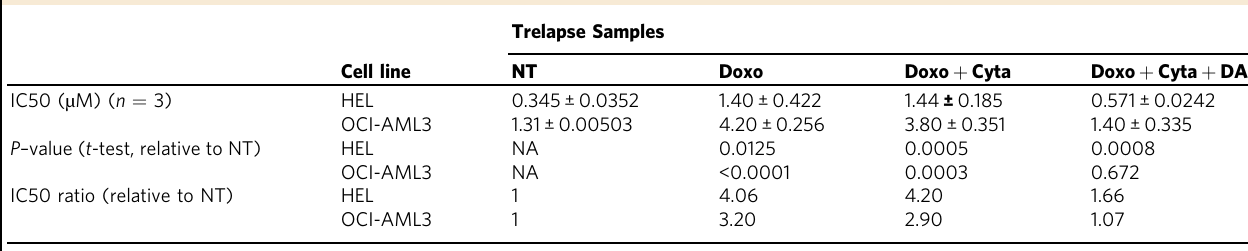
Table 1 Doxorubicin IC50 values of Trelapse hAML cells